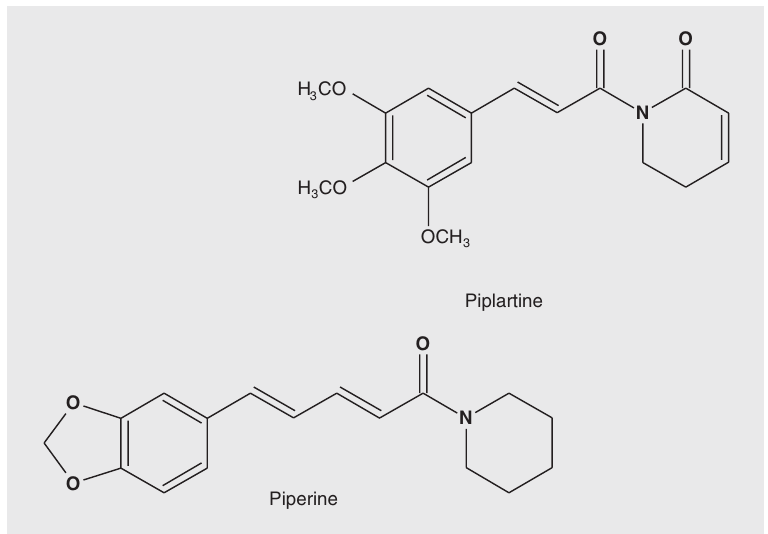
Figure 1. Chemical structure of piplartine {5,6-dihydro-1-[1-oxo-3-(3,4,5-trimethoxyphenyl)- 2-propenyl]-2(1H)pyridinone} and piperine {1-5-(1,3)-benzodioxol-5-yl)-1-oxo-2,4-